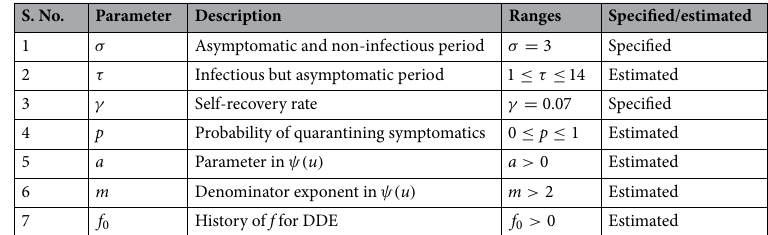
Table 2. Parameters used in the continuum model.